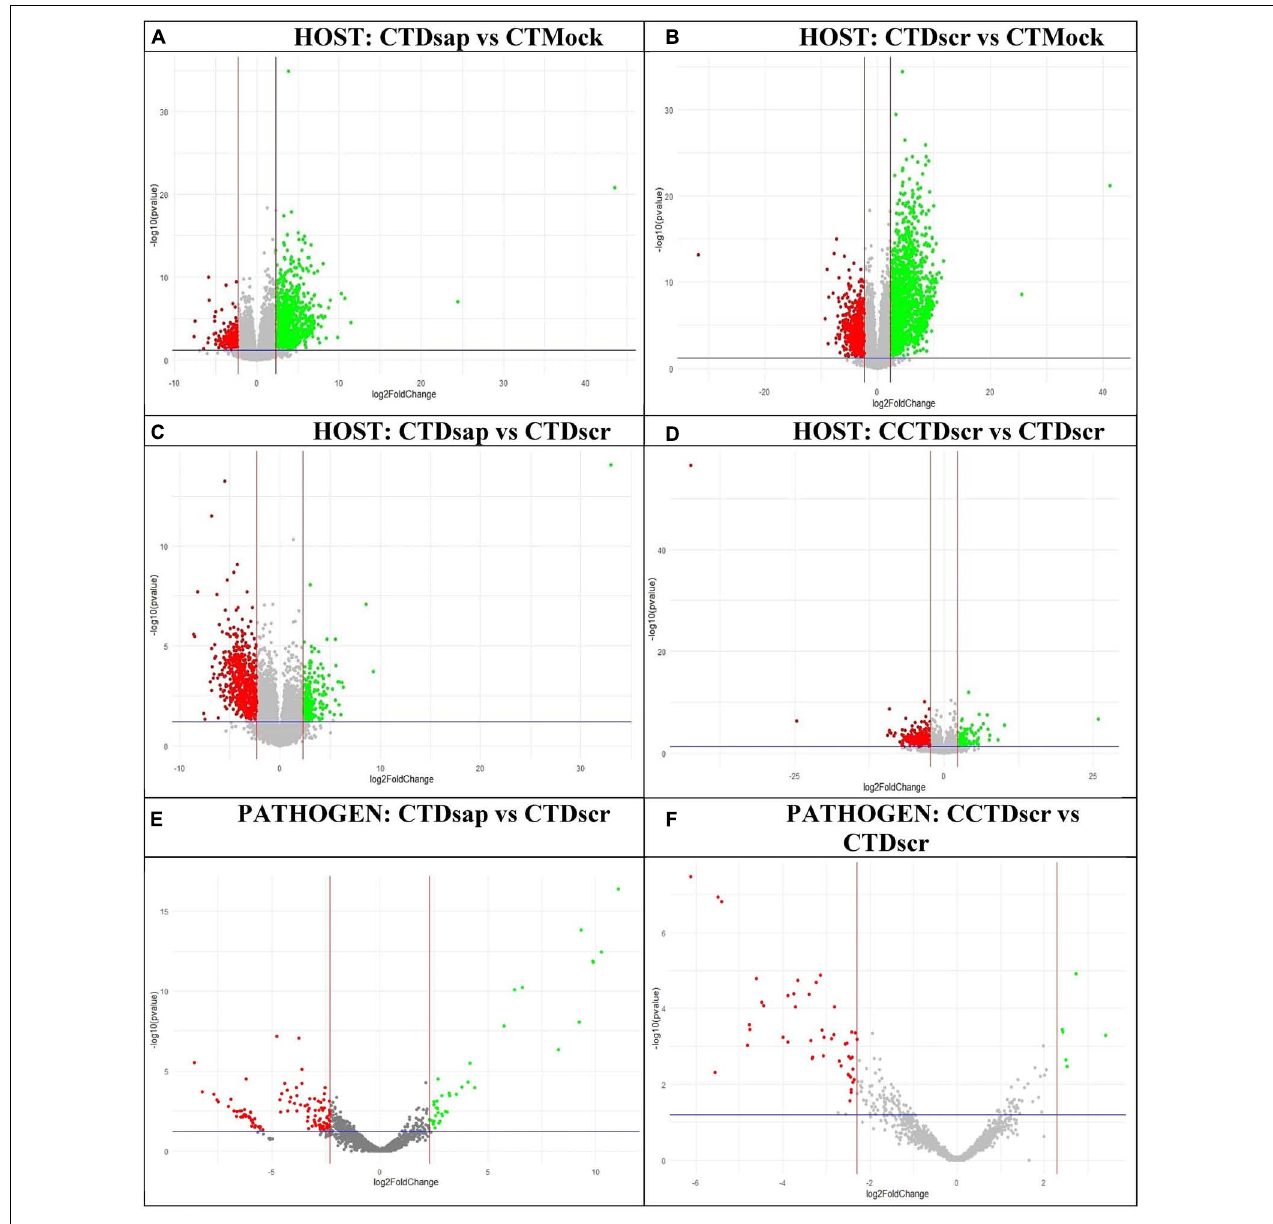
FIGURE 4 | Volcano plots of DEGs for individual host and pathogen comparisons. Upregulated and downregulated genes marked in green and red, respectively, based on actual fold-change > 5 (upregulated) or < –5 (downregulated) [i.e., log 2 (fold-change) > 2.3 (up) or < –2.3 (down)] and p < 0.05. Labels: (A)